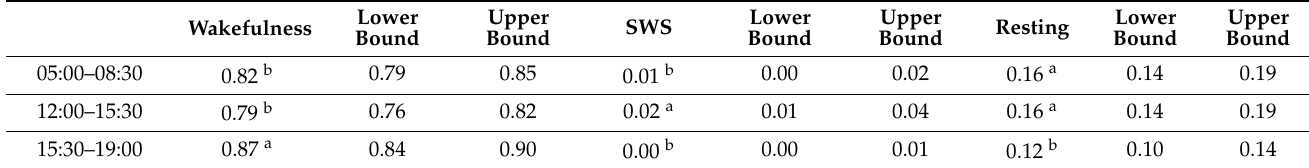
Table 8. Effects during lights on of time interval on proportions of states (wakefulness, slow-wave sleep (SWS) and resting behaviour). Values are back-transformed means, with back-transformed mean − SE and back-transformed mean + SE forming the lower and upper bounds, estimated from LMMs fitted to angular transformed proportions. Where superscripts are different within column, means are significantly different ( p < 0.05) (obtained through post hoc Tukey’s HSD tests). Lower